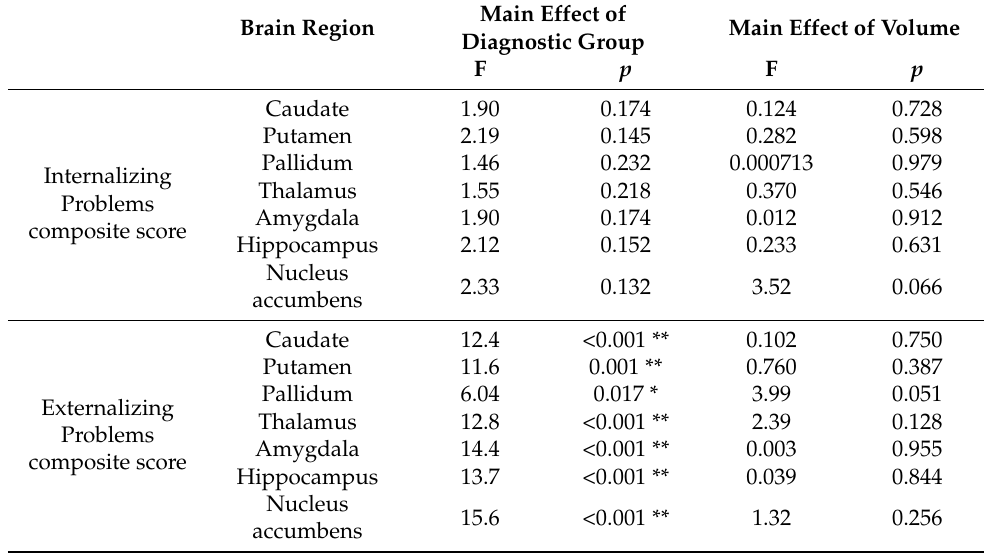
Table 6. Associations between volume and mental health symptoms in brain